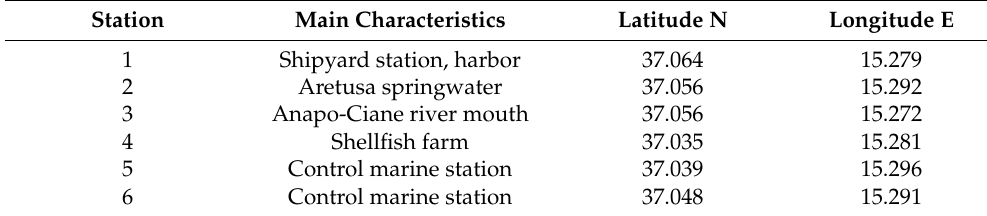
Table 1. Geographical coordinates of the sampling stations within Syracuse